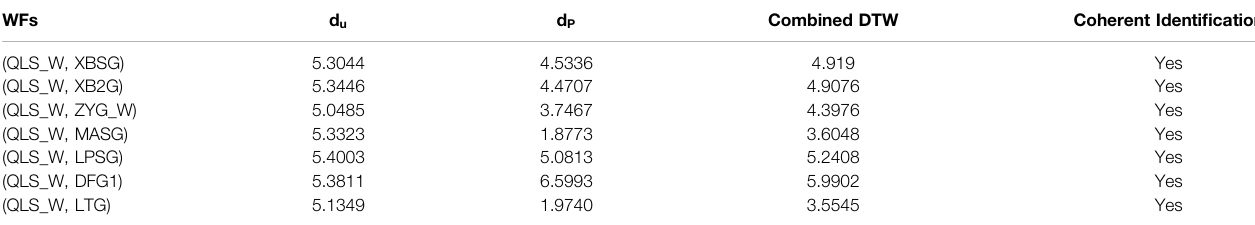
TABLE 1 | Results of combined DTW distance in Group 1.